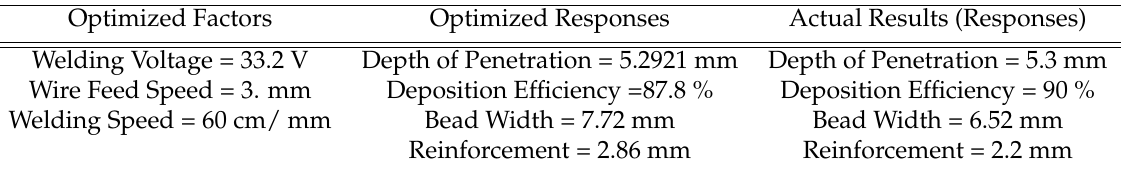
Table 11. Comparison between optimized and actual